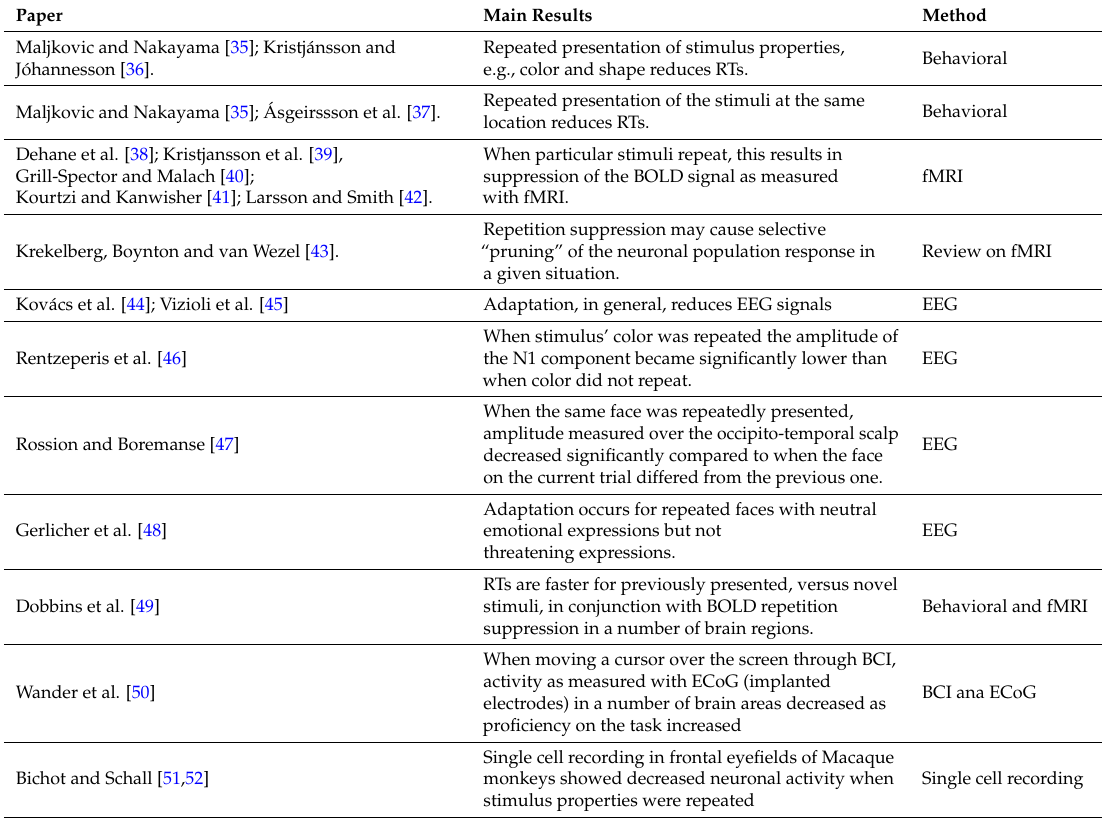
Table 2. Overview of the results reviewed in Section 3 (neural adaptation).